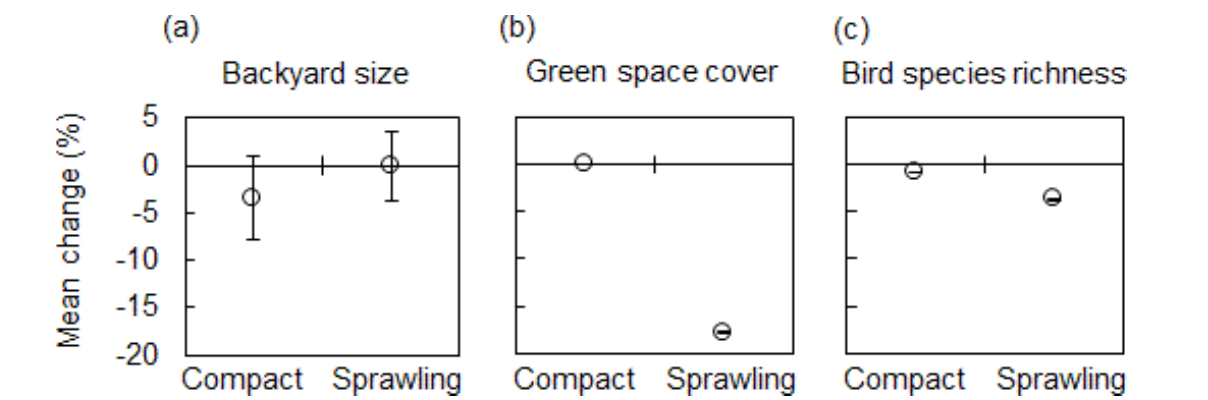
Fig. 1 . Changes in people’s opportunities to experience nature under compact and sprawling urban growth scenarios; (a) proportional change in mean backyard size (m²) per dwelling, (b) mean proportional change in the total area covered by public green space within a 500 meter radius of the home, and (c) mean proportional change in bird species richness within a 500 meter radius of the home. Data are means ± standard error; for green space cover and bird species richness standard errors were too small to visualize.